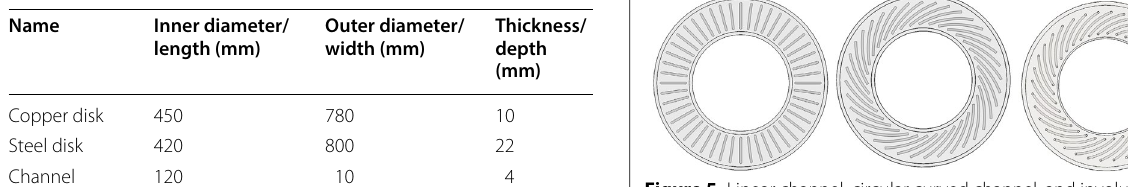
Figure 5 Linear channel, circular curved channel, and involute curved